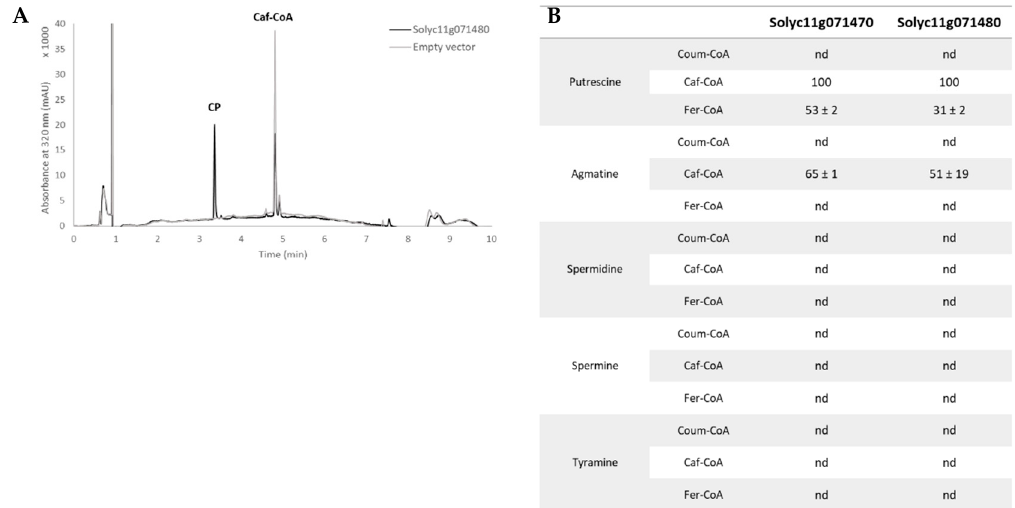
Figure 6. Functional identification of Solyc11g071470 and Solyc11g071480 as putrescine hydroxycinnamoyl-CoA transferase. ( A ) Chromatogram of biochemical assays realized on the purified enzymes; ( B ) table showing the substrate preference measured from the consumption of the acyl-CoA substrate and normalized to the best reaction. CP, caffeoyl putrescine; coum-CoA, p -coumaroyl-CoA; Caf-CoA, caffeoyl-CoA; Fer-CoA, feruloyl-CoA; nd, no activity detected.